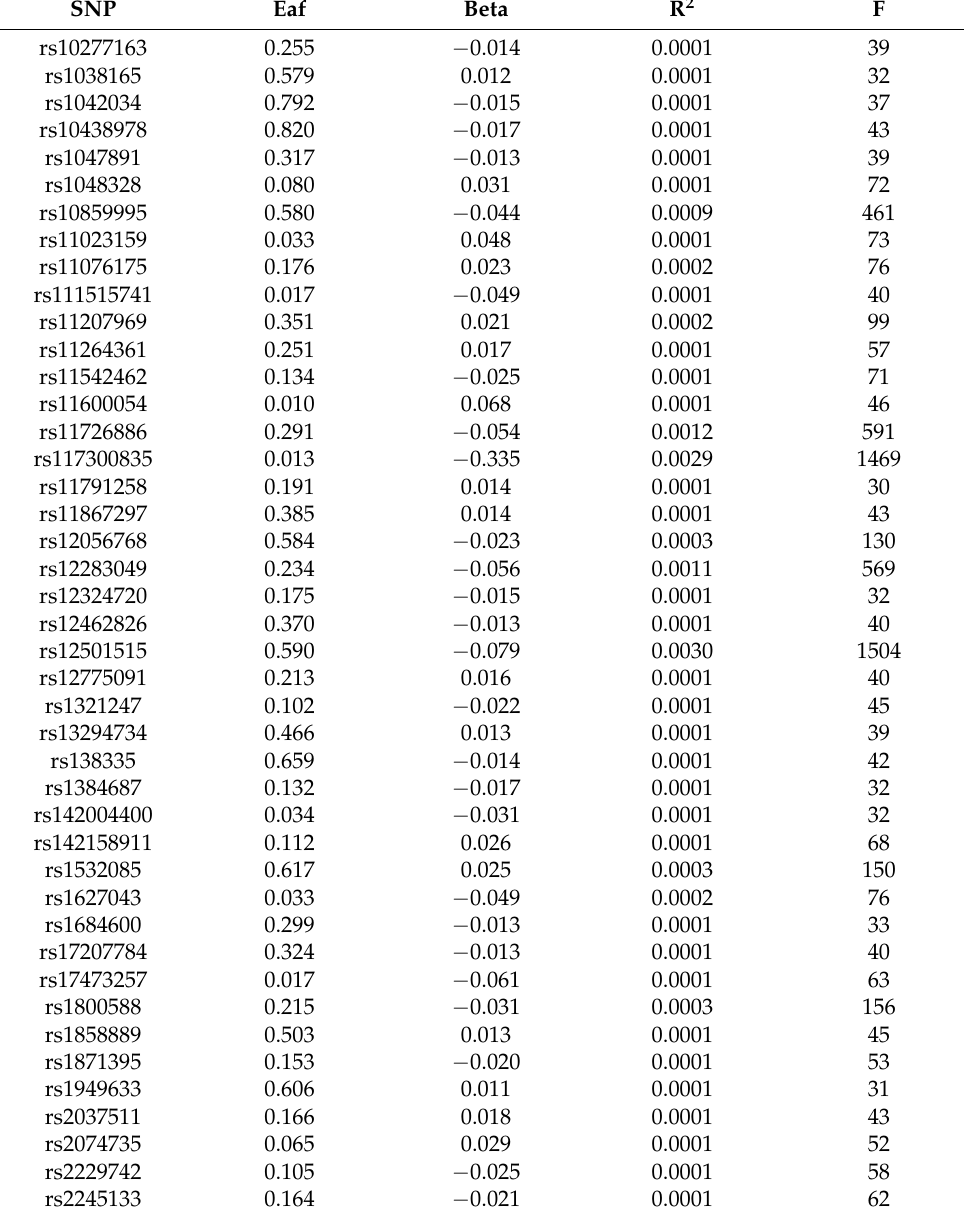
Table A1. The F statistics for SNPs strongly associated with vitamin